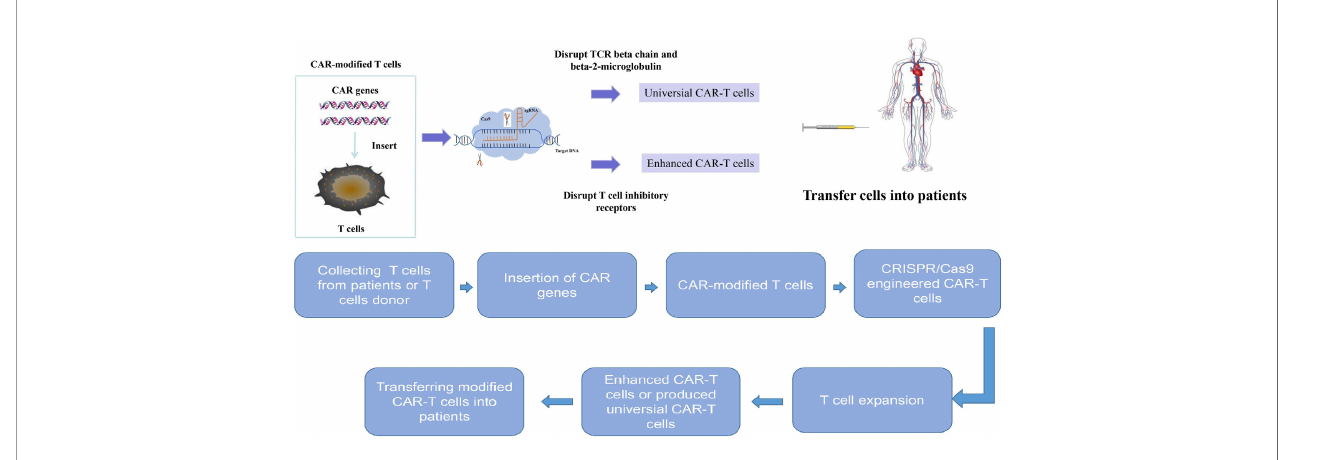
FIGURE 3 | The treatment process for combination of CRISPR/Cas9 technology and chimeric antigen receptor T cell therapy. CRISPR/Cas9 system can be used to genentate universal CAR-T cells and enhance CAR-T cell ef fi cacy. The treatment progress is as follows: T cells are collected from peripheral blood of patients and further activated and expanded. Then the chimeric antigen receptor genes were inserted into T cells to generate chimeric antigen receptor modi fi ed T cells. The chimeric antigen receptor T cells are engineered by CRISPR/Cas9 system to generate universal chimeric antigen receptor T cells or enhanced chimeric antigen receptor T cells. Then these engineered chimeric antigen receptor T cells are expanded in vitro and later transferred back to